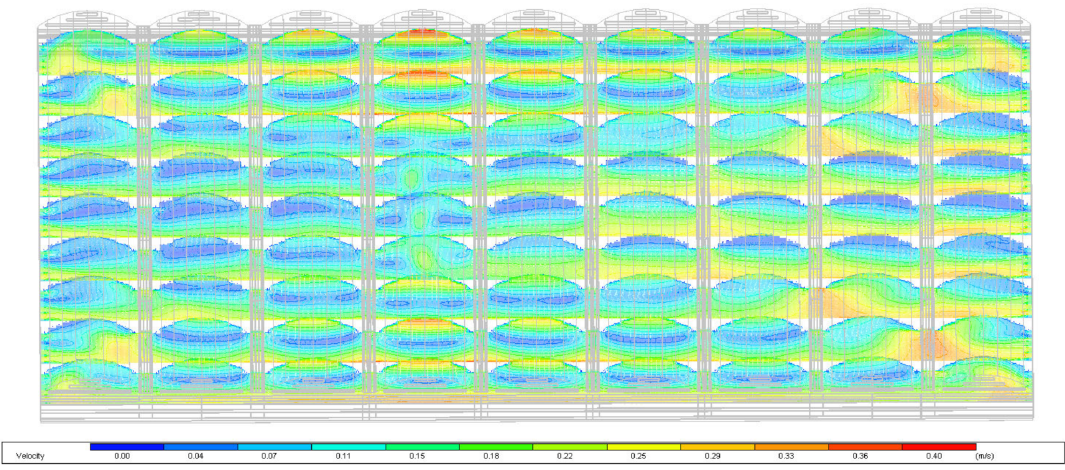
Figure 18. Wind speed cloud map of the multi-span round-arch greenhouse with an in-greenhouse ventilation channel (outdoor wind speed 0 m/s).